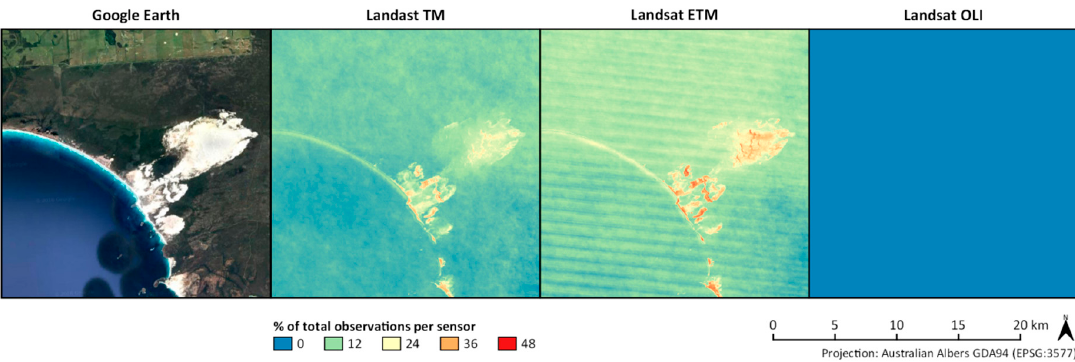
Figure 6. Saturation characteristics of the BLUE band across the Landsat TM, ETM+, and OLI sensors at Cape Arid, WA: high-resolution imagery (Google, CNES/Airbus, TerraMetrics, DigitalGlobe) and percentage of saturation flags to total observations.